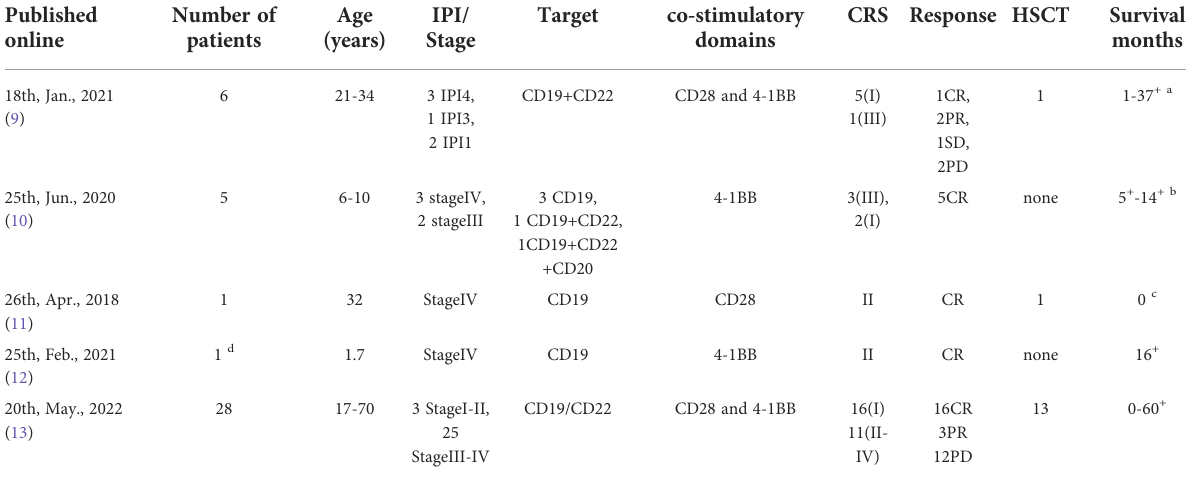
TABLE 1 Treatment and outcomes from prior trials of CART cell therapy for Burkitt lymphoma (Literature review). Published online